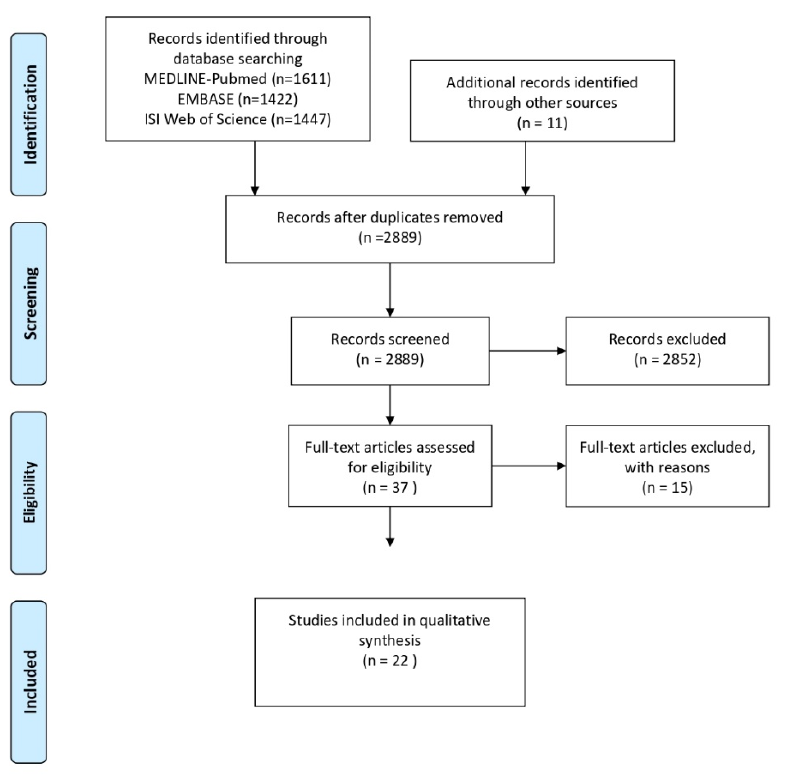
Figure 1. Preferred Reporting Items for Systematic Reviews and Meta-Analyses (PRISMA) flow diagram for study selection.